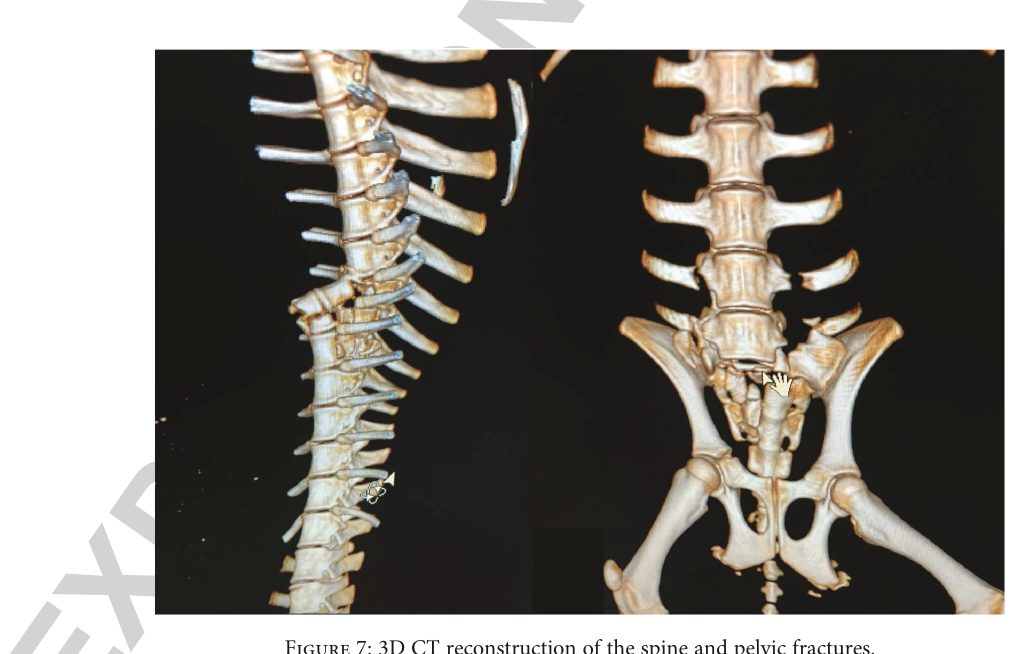
Figure 7: 3D CT reconstruction of the spine and pelvic